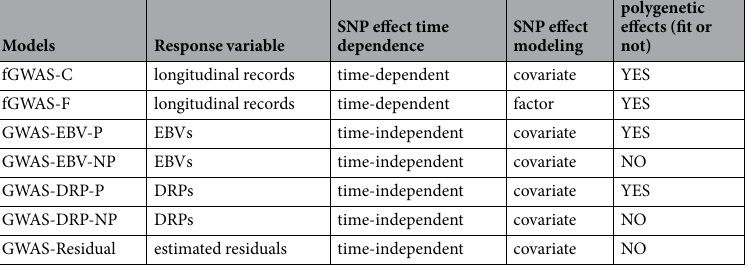
Table 2. The characters of fGWAS-C, fGWAS-F, GWAS-EBV-P, GWAS-EBV-NP, GWAS-DRP-P, GWAS- DRP-NP, and GWAS-Residual